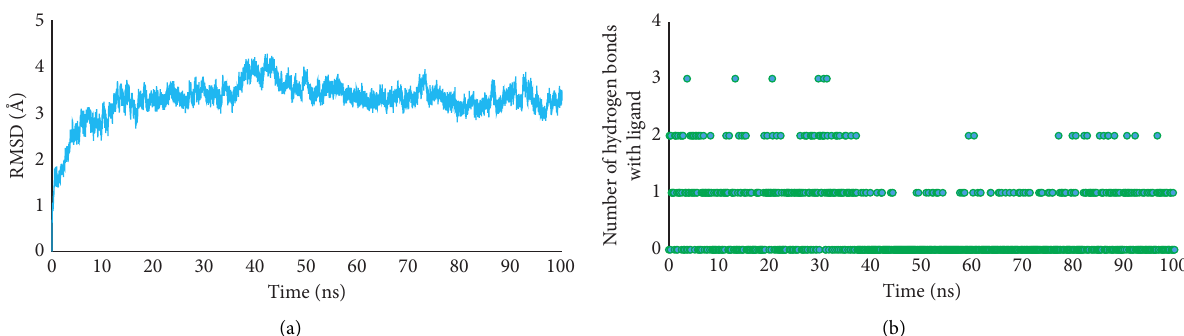
Figure 3: RMSD evolution of the protein backbone atoms of the complex (a) number of hydrogen bonds made between protein residues and the ligand 4i (b).